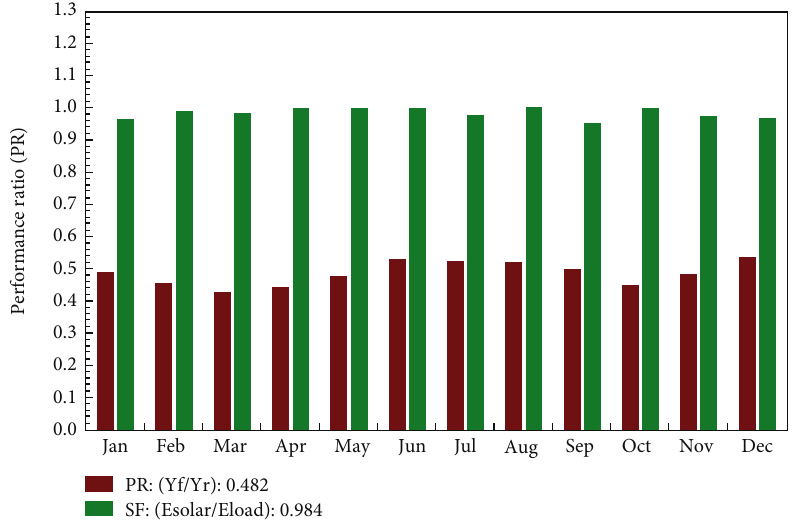
Figure 7: O ff -grid PV power generation